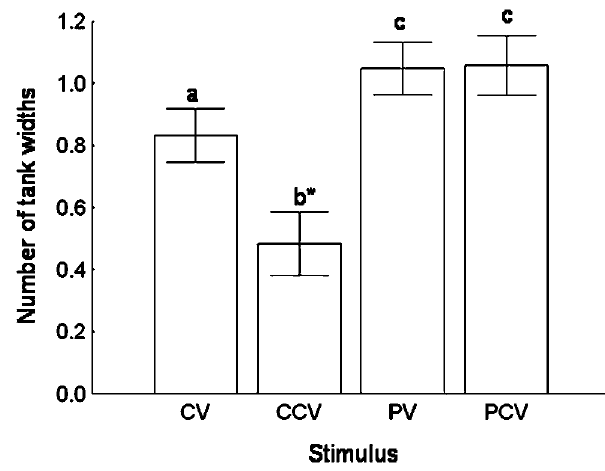
Figure 3. Comparisons of Mean Distances from Visual Stimuli This figure shows that fry (1) stayed further away from predators than they did from adult conspecifics, and (2) were most attracted to adult conspecifics when they could see and smell them (in conspecific chemical visual trials (CCV)). Bars and whiskers represent the mean 6 SE. Means with different letters above them are significantly different ( p , 0.05; asterisk: p , 0.01).